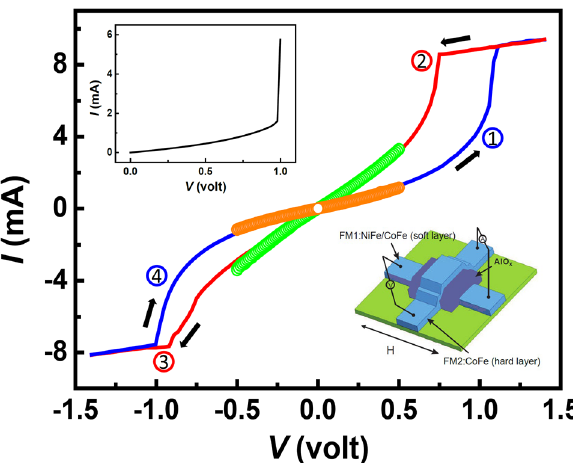
Figure 1. Current–voltage (I–V) curves of a NiFeCoFe/ AlO x /CoFe MTJ structure with arrows indicating the directions of the voltage sweep. The different colors of the I–V curves represent different directions and ranges of the sweep (see details in the text). The upper-left inset shows the electroforming process, in which a relatively high positive bias is applied on the CoFe electrode. The lower-right inset shows the schematic of the device